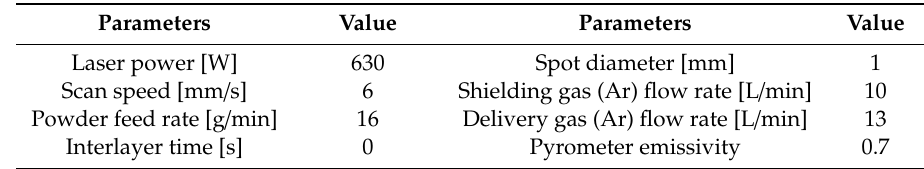
Table 2. Process parameters for LMD .